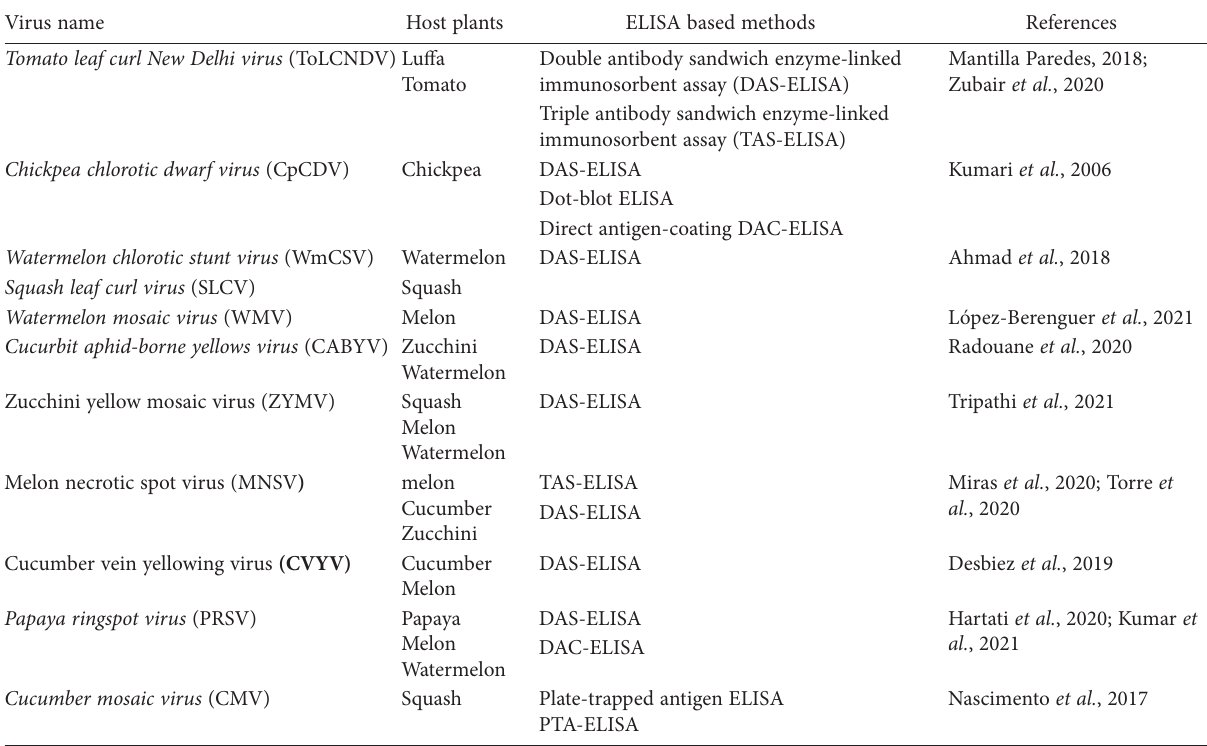
Table 2. Serological tests, based on ELISA and its modified methods, used for detection of cucurbit-associated